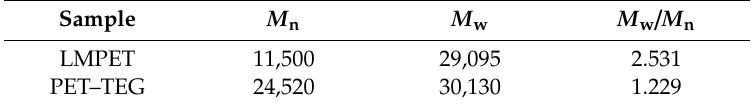
Table 1. The molecular weight of poly(ethylene terephthalate)–tetraglycol (PET–TEG).